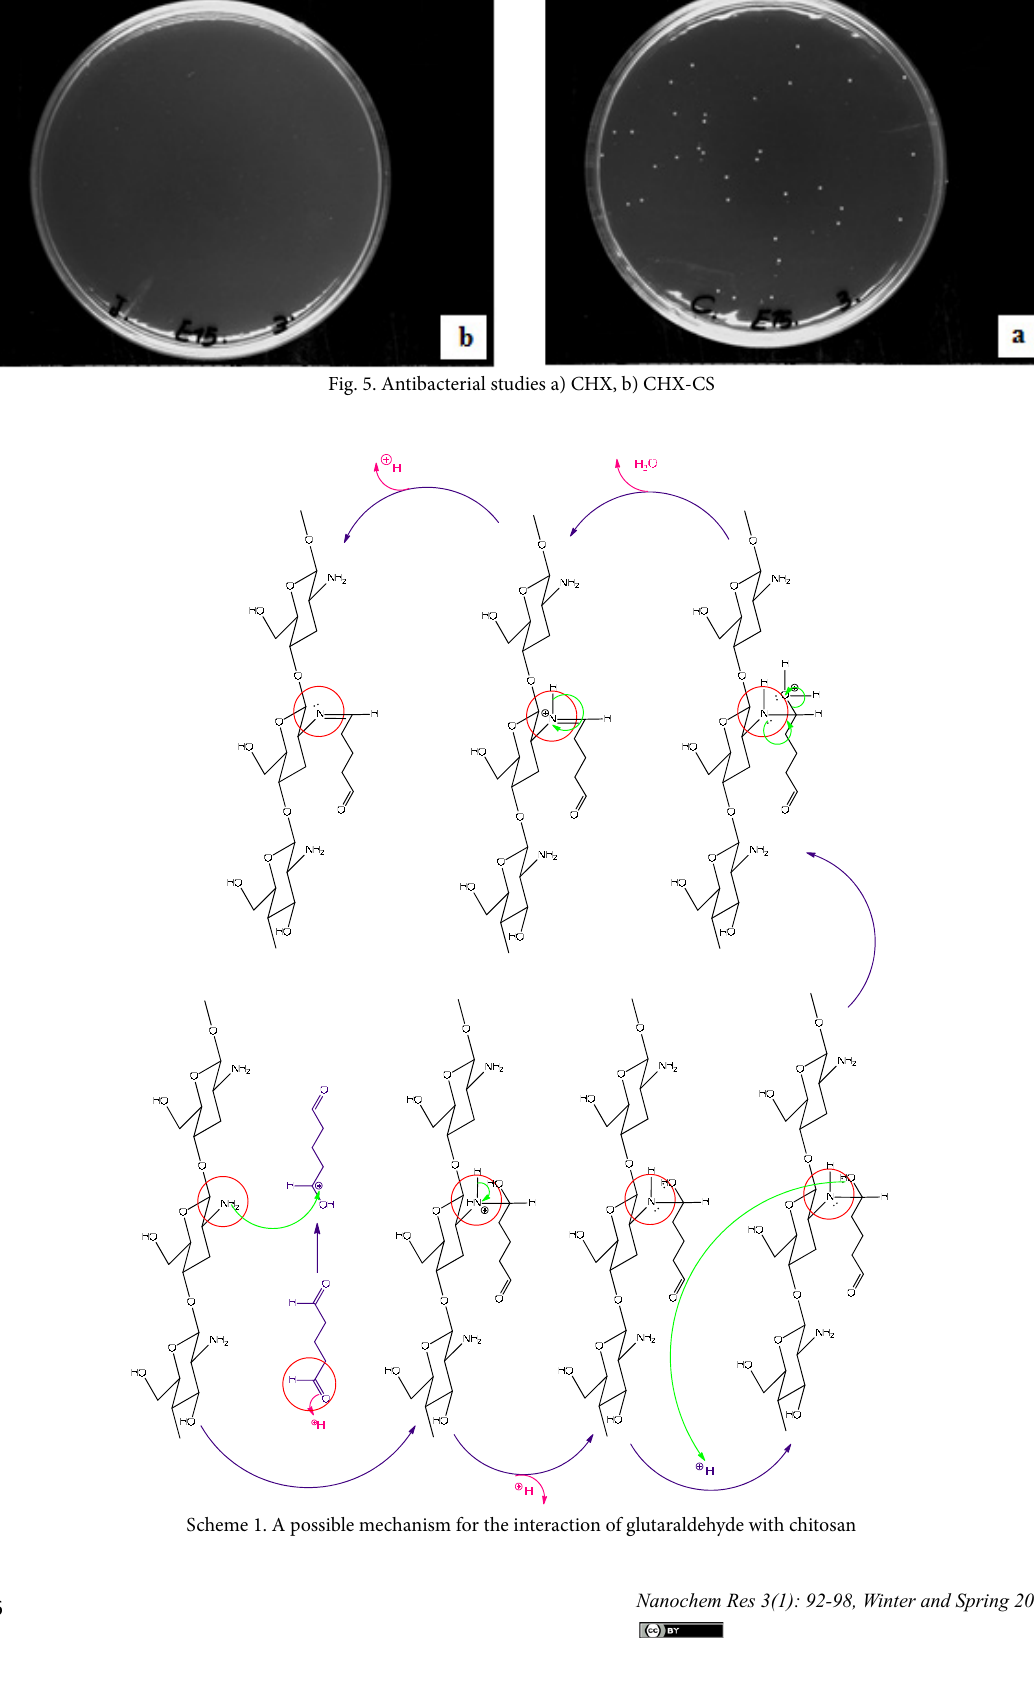
Nanochem Res 3(1): 92-98, Winter and Spring 2018